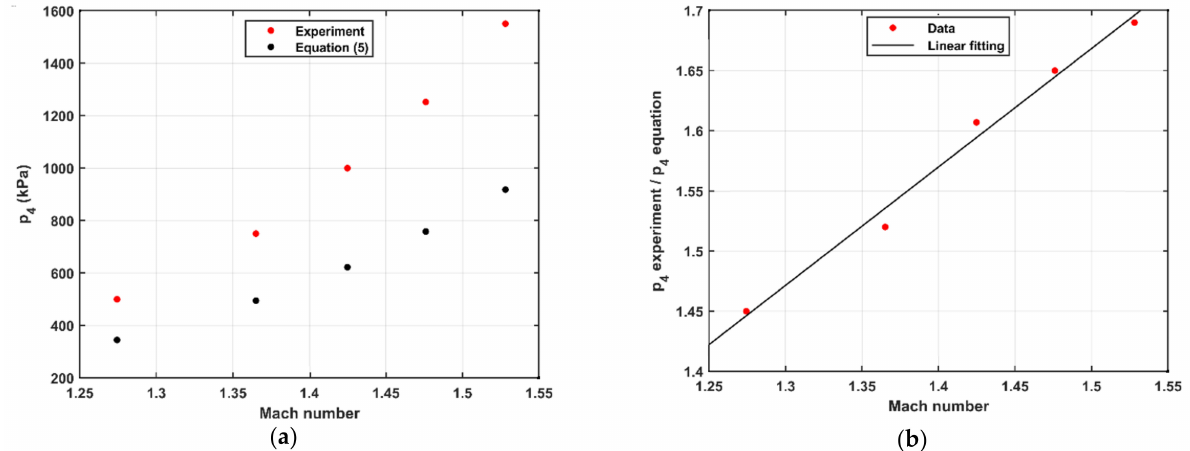
Figure 5. ( a ) The driver pressure ( p 4 ) as a function of Mach number and ( b ) ( p 4 experiment/ p 4 equation) as a function of Mach number when using Ar as a driver gas; p 1 is 100 kPa(a).